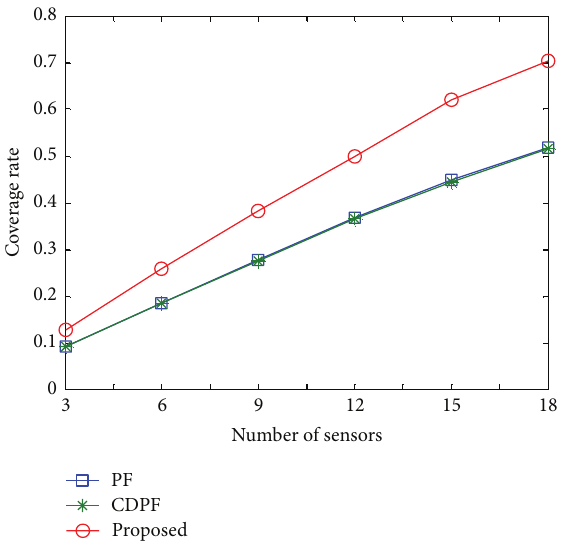
Figure 9: Ideal moving distance versus number of